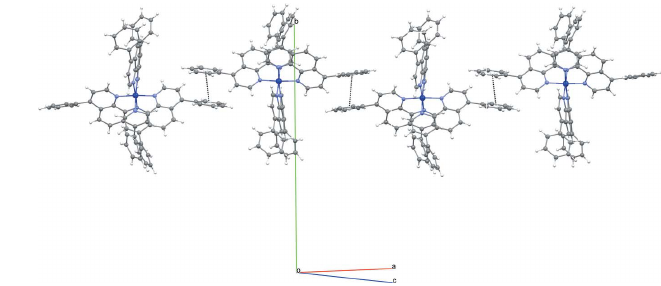
Figure 2 A view of the crystal packing showing (cid:2) – (cid:2) stacking interactions forming chains extending perpendicular to the b